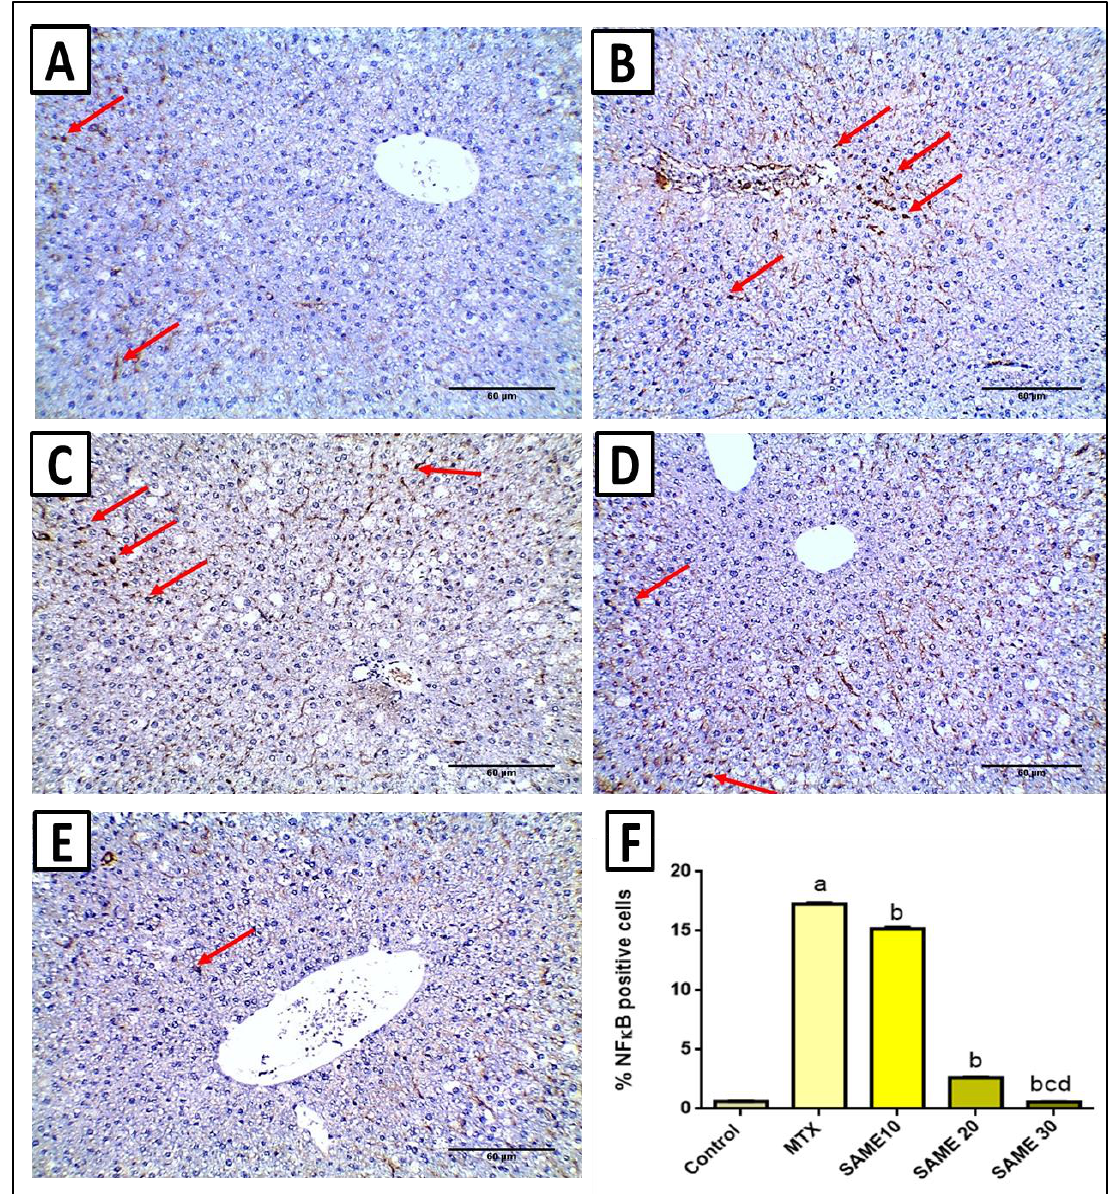
Figure 9. Effects of the SAME pretreatment on immunohistochemical staining of NF-κB. ( A ) A section in the liver of the normal control group showed negative immunostaining in hepatocytes (nuclear positivity in less than 1% of hepatocytes) (red arrows) [×200]. ( B ) A section in the liver of the MTX group showed positive nuclear staining in more than 10% of hepatocytes score 2 (red arrows) [×200]. ( C ) A section in the liver of the SAME 10 pretreated group showed positive nuclear staining in more than 10% of hepatocytes score 2 (red arrows) [×200]. ( D ) A section in the liver of the SAME 20 pretreated group showed positive nuclear staining in 1–10% of hepatocytes score 1 (red arrows) [×200]. ( E ) A section in the liver of the SAME 30 pretreated group showed negative immunostaining in hepatocytes (nuclear positivity in less than 1% of hepatocytes) (red arrows) [×200]. ( F ) Percentage of positive cells/1000 cells per 10 high power fields . Data expressed as mean ± SD. Significant differ- ence vs. a respective control, b respective MTX group, c respective SAME 10 group, d respective SAME 20 group each at p < 0.05. 2.7. Histopathological Studies Liver slices from the normal control group were examined histopathologically and illustrated portal tract (portal venule, hepatic arteriole, and bile ductule) surrounded by cords of hepatocytes (Figure 10A). In contrast, liver sections of the MTX group showed a